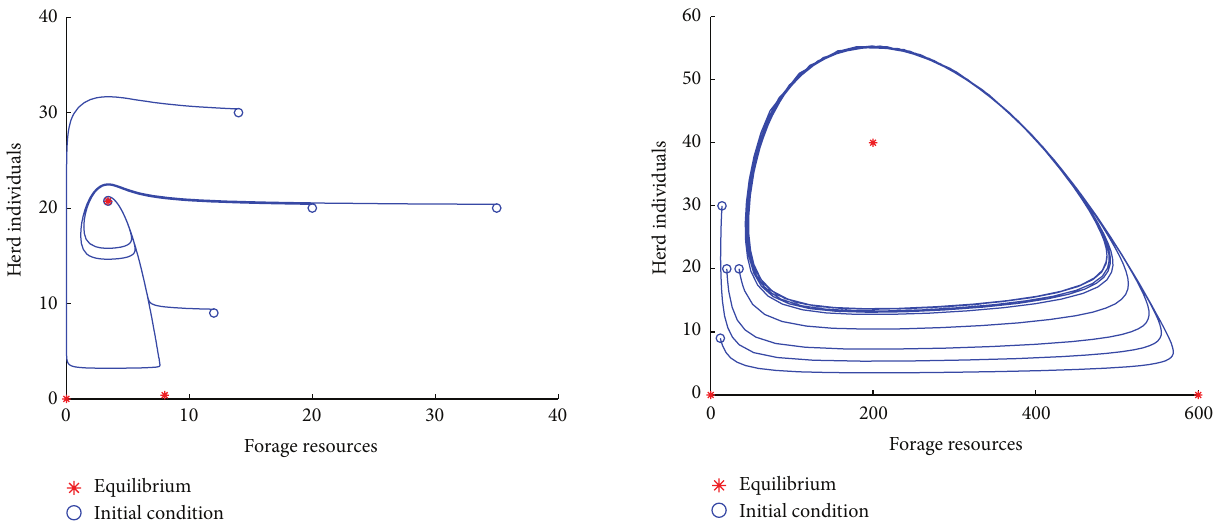
Figure 8: Phase portrait for illustration of a stable limit cycle around coexisting equilibrium of System (1) for 𝐸 2 = (𝑅 ∗ , 𝐻 ∗ ) for 𝑟 = 700 kgDM/ha, 𝑒 = 0.05/ day, 𝑎 = 0.013/ ha, 𝐾 = 960 kgDM/ha, 𝑞 = 0.4/ day, and 𝛾 = 1.0/ day. This means that there is a supercritical Hopf bifurcation.